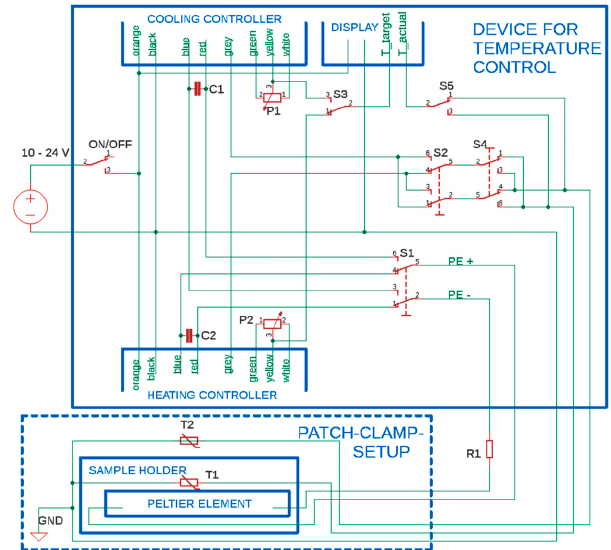
Figure 2. Top: Circuit inside 3D printed housing. Bottom: Microscope inset. P 1 , P 2 : Potentiometer for temperature adjustment. T 1 , T 2 : Thermometers. S 1 , S 2 , S 3 : Switching between heating and cooling. S 4 : Thermometer selection for the controllers. S 5 : Thermometer selection for the display. R 1 , C 1,2 : Low-pass filter and current matching. (Appendix